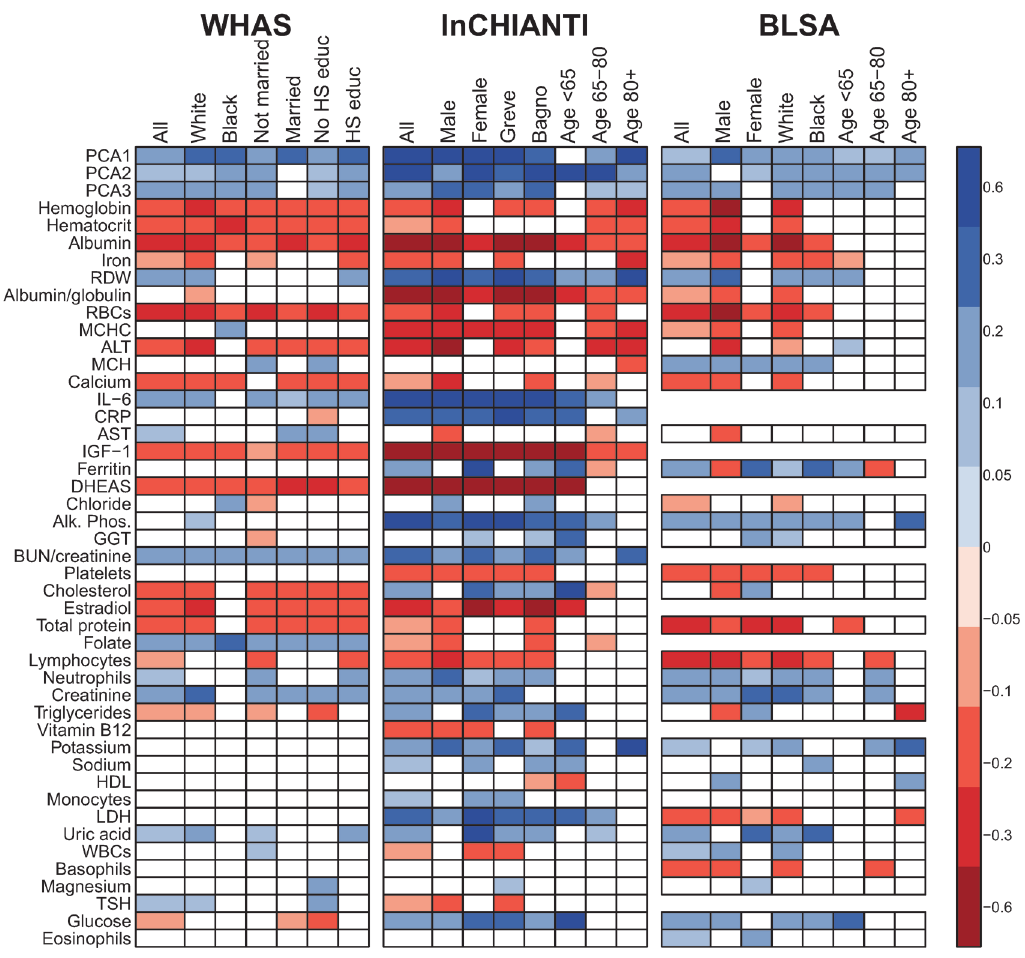
Fig 9. Stability across datasets of correlations between age and PCA axes or biomarkers. Biomarkers are sorted from highest to lowest |loading| in PCA1. Colored boxes indicate significant correlations ( p < 0.05) with darker shading indicating stronger correlation (blue = positive, red = negative). Note that many biomarkers are significantly correlated in opposite directions in different datasets. Boxes are absent for variables with insufficient sample size in the respective dataset. The weak correlation between age and PCA1 in the youngest subgroup is expected given the non-linear relationship with age (Fig.